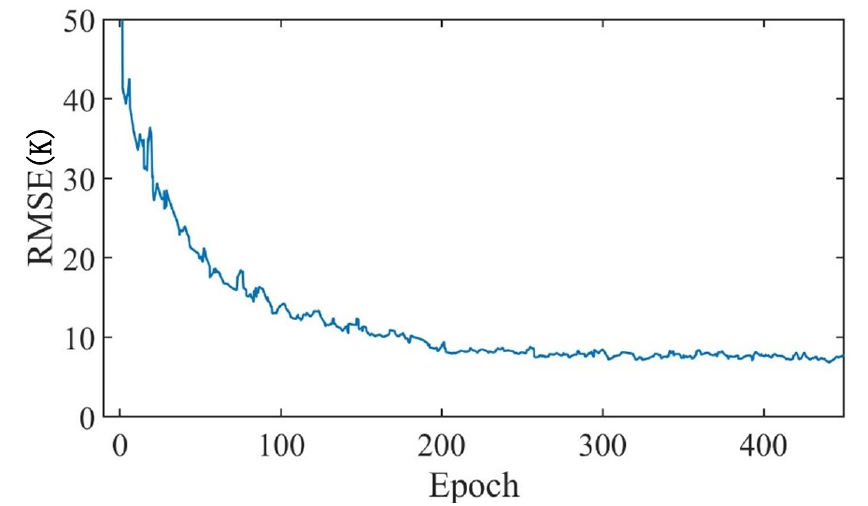
Figure 4. The RMSE convergence trend.